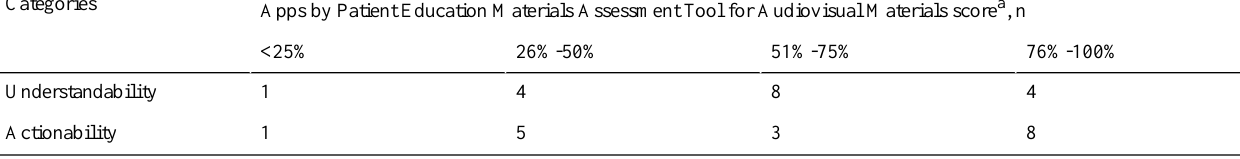
Table 5. Patient education material assessment tool audiovisual scores. Apps by Patient Education Materials Assessment Tool for Audiovisual Materials score a ,